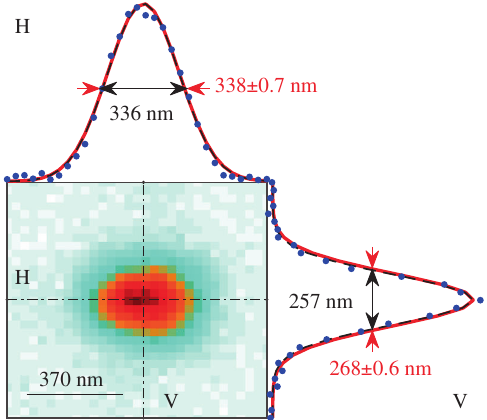
Fig. 3 Sub-wavelength image of an 174 Yb + ion by an integrated diffractive mirror. Near diffraction limited performance was obtained from a rectangular optic 80 × 127 μ m operating at NA = 0.56 × 0.73 covering a solid angle Ω /4 π = 13.3%. Imaged at magni fi cation 390×, 1 s exposure. Horizontal (H) and Vertical (V) cross sections indicate image data ( blue points ), 338(0.7) × 268(0.6) nm FWHM diameter gaussian fi ts ( red ), and predicted diffraction limit ( black dashed